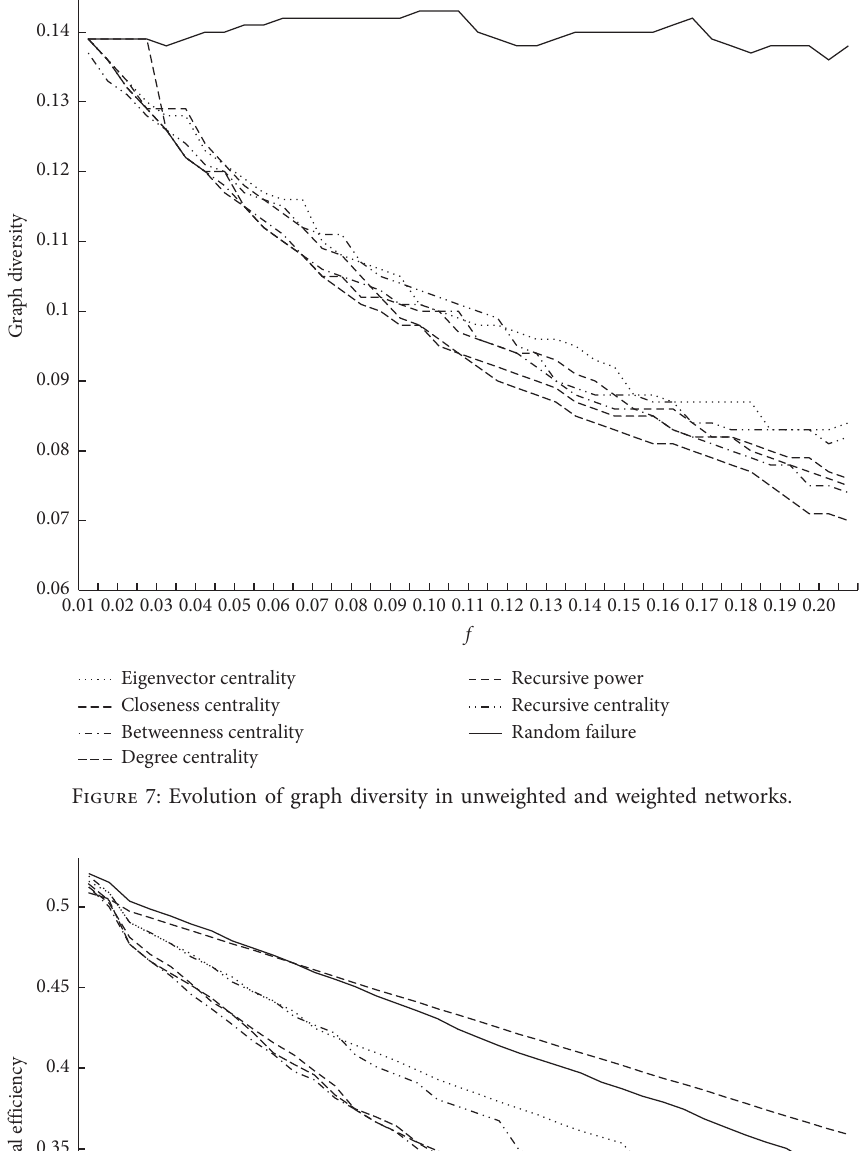
Figure 7: Evolution of graph diversity in unweighted and weighted networks.